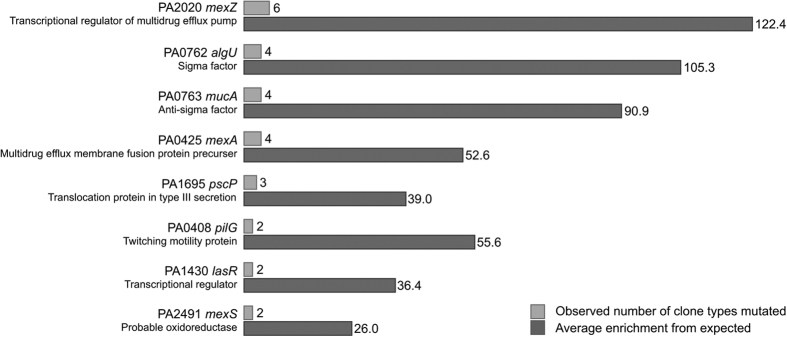
Genes mutated in more clones than would be expected by genetic drift.(A) Overview of the number of clones observed to be mutated in each gene, and the enrichment of genes mutated relative to expectance (p < 0.0001). (B) Overlap of the genes found to be important for the adaptation of Pseudomonas aeruginosa to the PCD airways, and genes found important for the adaptation to CF airways in three other studies: Smith (2006)16, Marvig (2013)15, and Marvig (2015)17. It should also be noted, that even though the genes lasR and mucA are not on the pathoadaptive gene list of Marvig (2013)15, they were found to have been mutated in all isolates; however, the mutations had happened in an ancestor isolate.